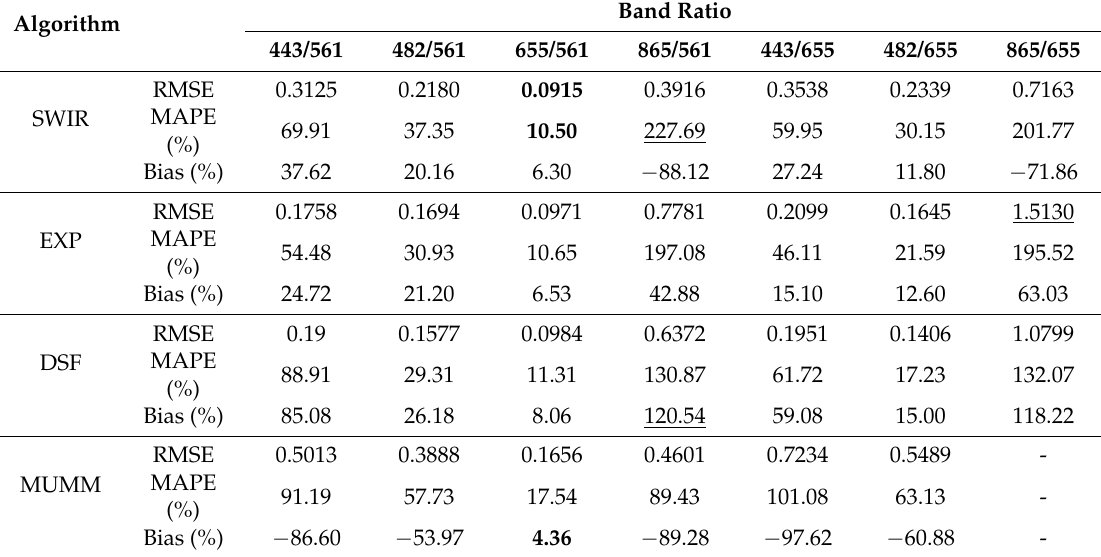
Table 5. Band ratio errors between in situ R rs and OLI R rs obtained with atmospheric correction algorithms for water. The bold means the minimal statistical value and the underline means